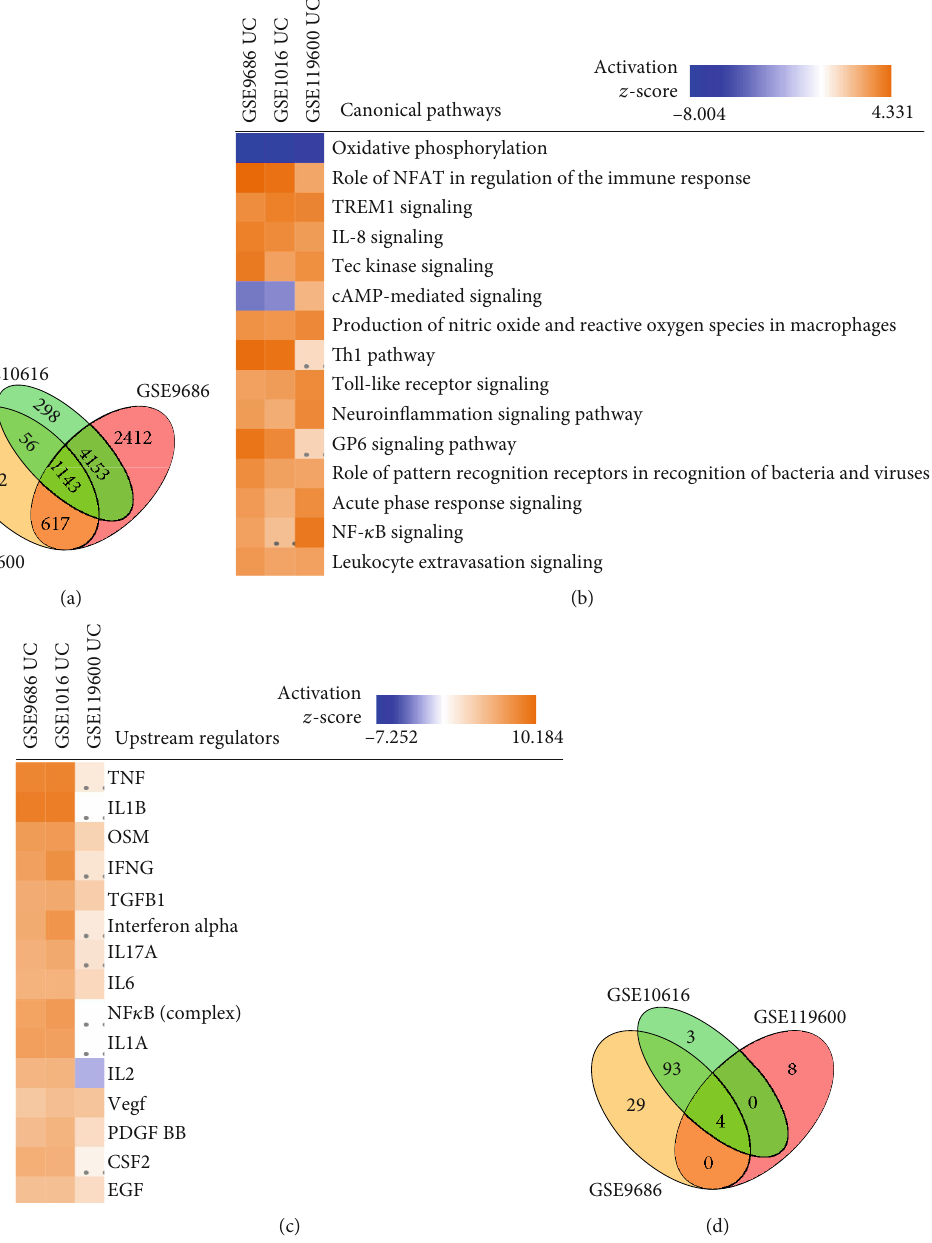
Figure 3: Ingenuity pathway analysis of expression pro fi ling datasets of whole blood cells and colon biopsies from patients with ulcerative colitis. GSE119600 was the dataset of whole blood cells and GSE9686 and GSE10616 were datasets of colon biopsies. (a) Venn diagram of di ff erentially expressed genes from the three datasets. (b) Canonical pathway comparisons between the three datasets. Orange indicates upregulated, and blue indicates downregulated pathways. Color intensity corresponds to signi fi cance. (c) Predicted upstream regulators of the mapped di ff erentially expressed genes. (d) Venn diagram of predicted overlapped biomarkers from the three datasets. Dots mean a nonsigni fi cant